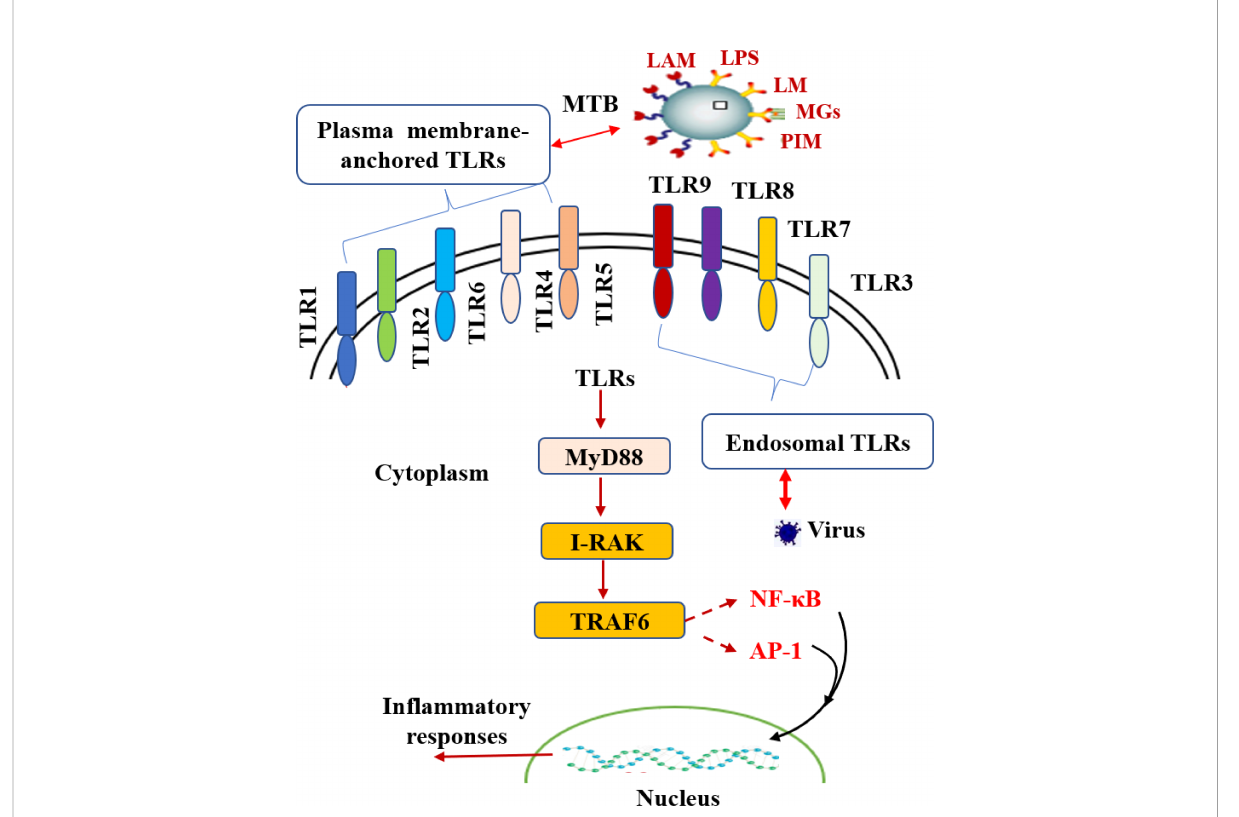
FIGURE 4 The interaction between TLRs and MTB infection. TLRs play a vital role in TB infection. Toll-like receptors are divided into plasma membrane-anchored TLRs and endosomal TLRs according to the localization of TLR proteins. As TLRs are activated, they activate downstream IRAK, TNFR and TRAF-6 through the MyD88-dependent signaling pathway, further activating NF-kB and AP-1 and producing a series of in fl ammatory